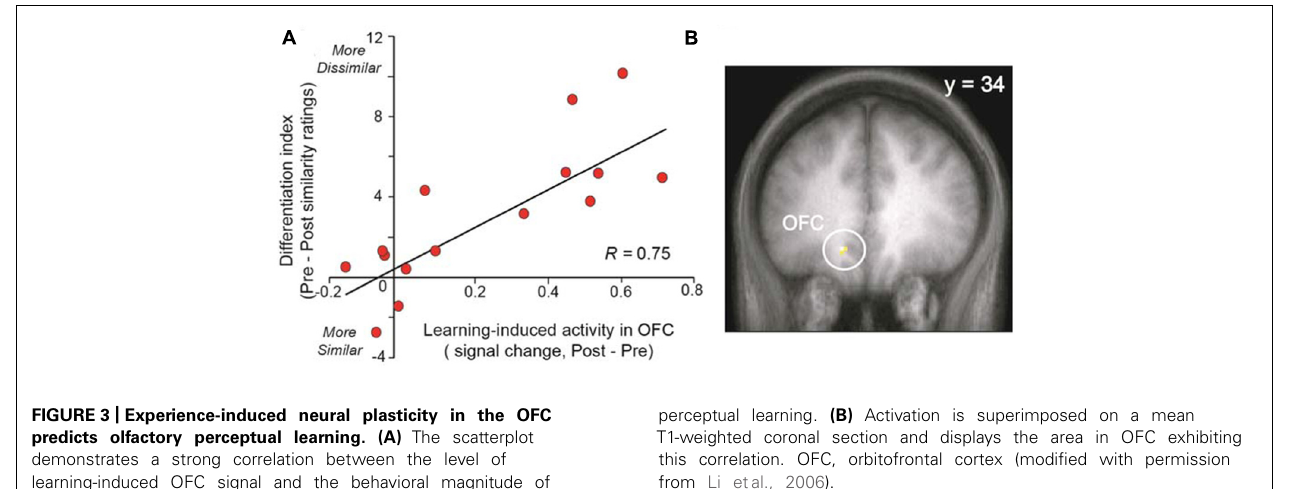
FIGURE 3 | Experience-induced neural plasticity in the OFC predicts olfactory perceptual learning. (A) The scatterplot demonstrates a strong correlation between the level of learning-induced OFC signal and the behavioral magnitude of